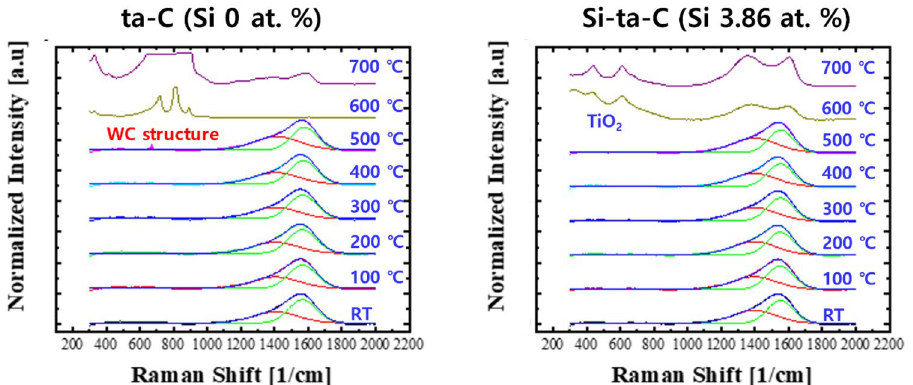
Figure 7. Raman spectra of tetrahedral amorphous carbon (ta-C) and 3.86 at.% Si-incorporated ta-C (Si–ta-C) coatings before and after annealing at elevated temperature.